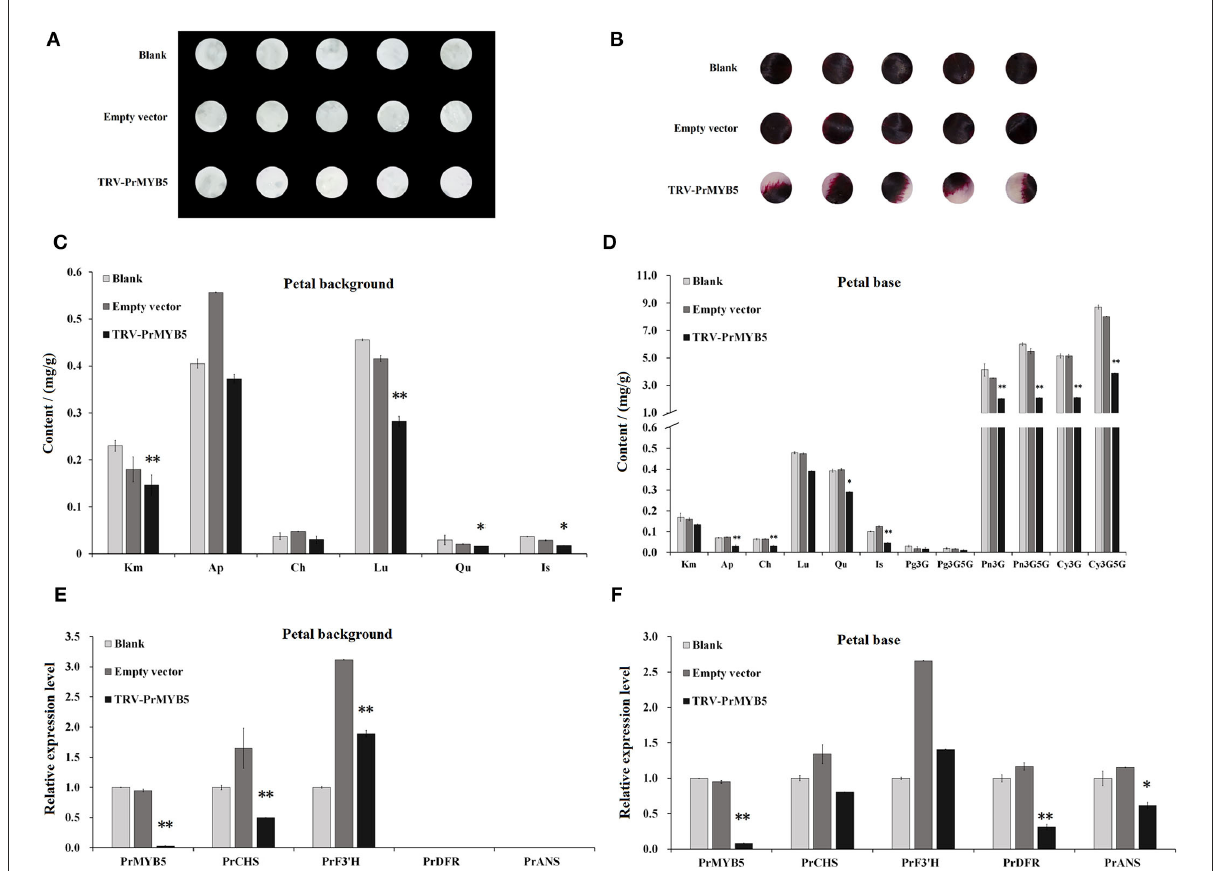
FIGURE6 Transient silencing of PrMYB5 in P. rockii petals using virus gene silencing (VIGS). Phenotypes of petal background disc (A,B) . The flavonoids accumulation in the petal background disc (C) and petal base disc (D) . The expression levels of PrMYB5 and structural genes in petal background disc (E) and petal base disc (F) . * Indicates significant differences at P < 0.05; ** indicates relatively significant differences at P <